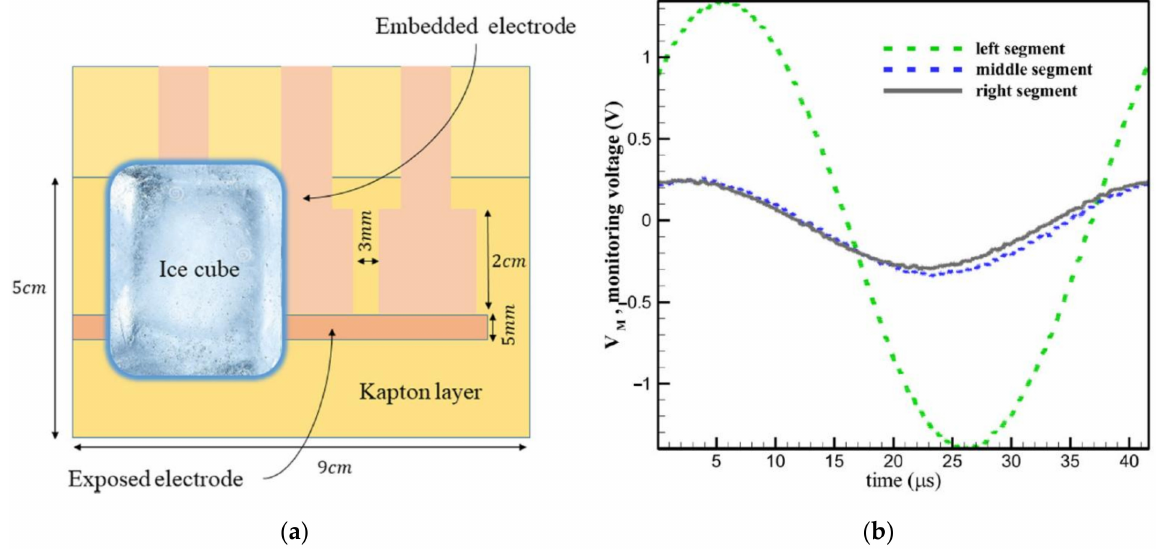
Figure 28. Segmented encapsulated electrode configuration for ice location detection: ( a ) Schematic of the actuator configuration with three segmented electrodes. ( b ) Variation of the monitoring voltage at each segmented electrode with the ice cube on the left side (reproduced from Rodrigues et al.